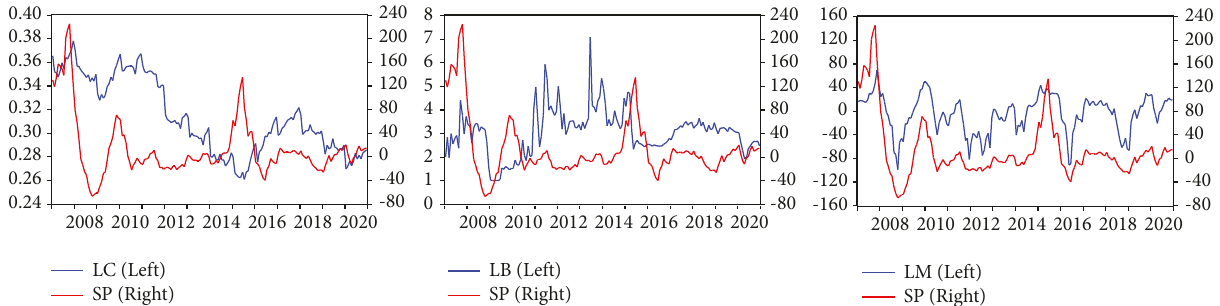
Figure 2: The volatility trend of China’s real estate market (a) and the smoothing probability of its volatility state (b).